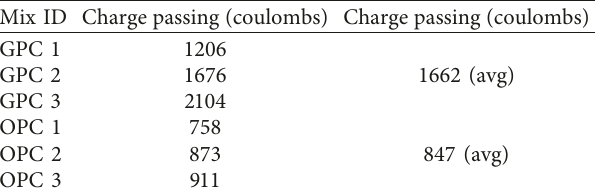
Table 9: RCPT values for different concrete mixes.